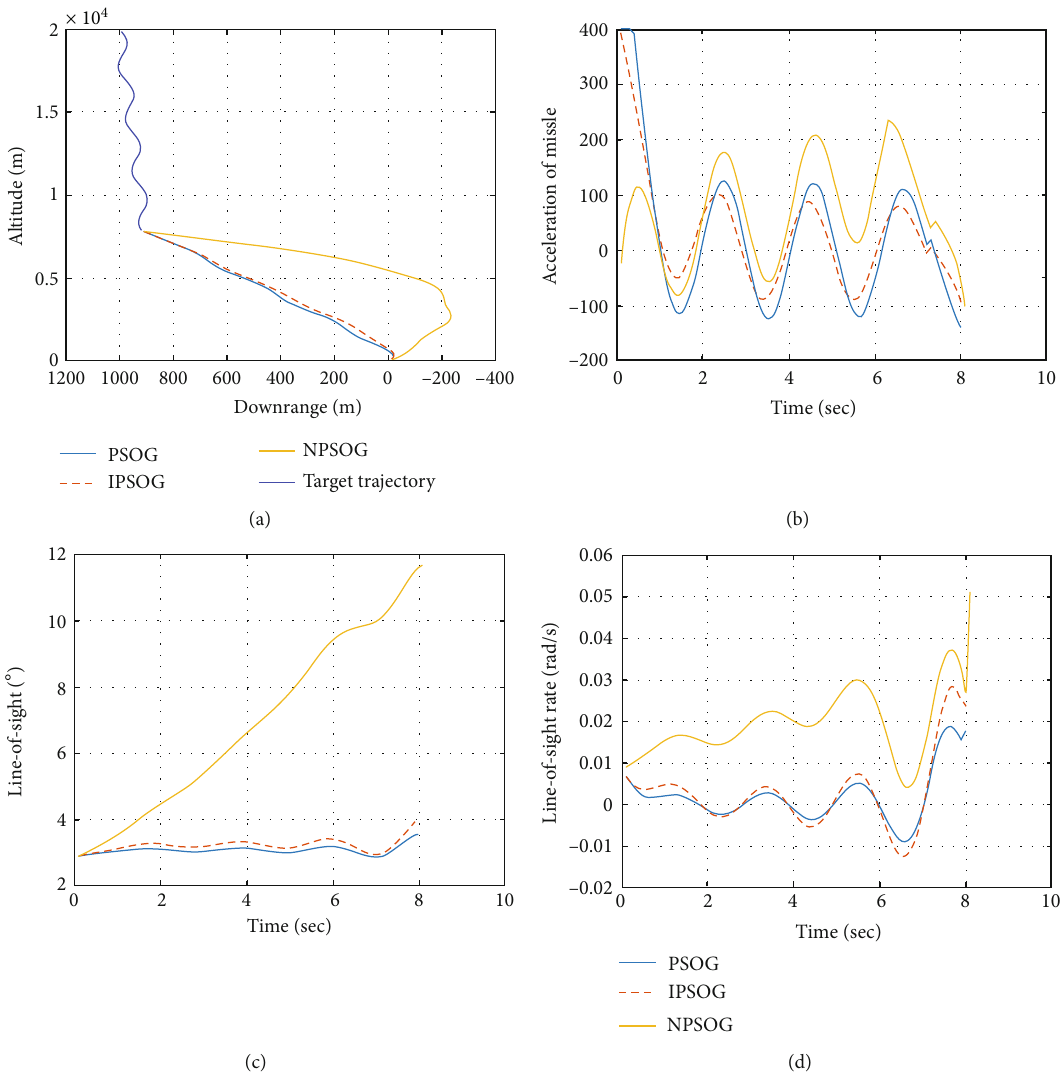
Figure 6: Simulation results of intercepting weave-maneuvering hypersonic